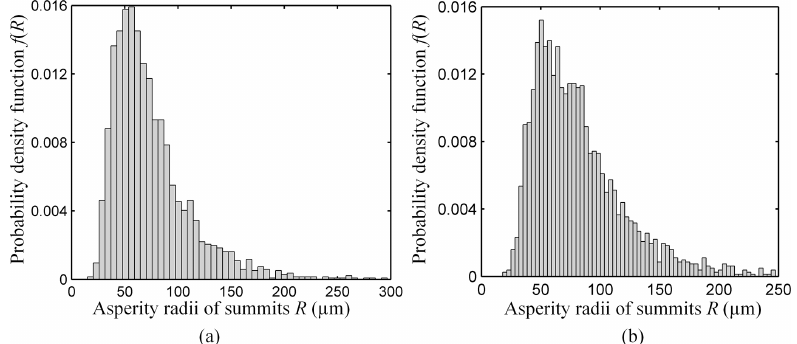
Figure 10. Statistical distribution of asperity radii of summits of the measuring surface. (a) Turning specimen and (b) milling